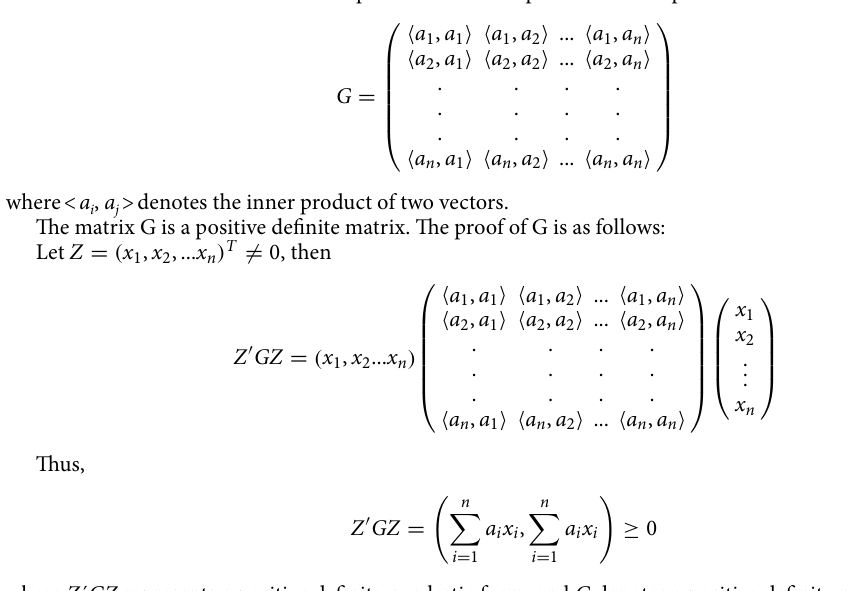
Time domain image conversion based on Gram matrix. The time attribute is an important attribute to determine the classification. Due to the different time attributes, different regular distributions are presented in chronological order. Therefore, this paper proposes a time-domain image conversion based on the Gram matrix. This method can retain the time attributes and convert a time series into an N × N two-dimensional matrix without loss. The Gram matrix G is a matrix composed of the inner product of each pair of vectors in the form of Eq. (4):